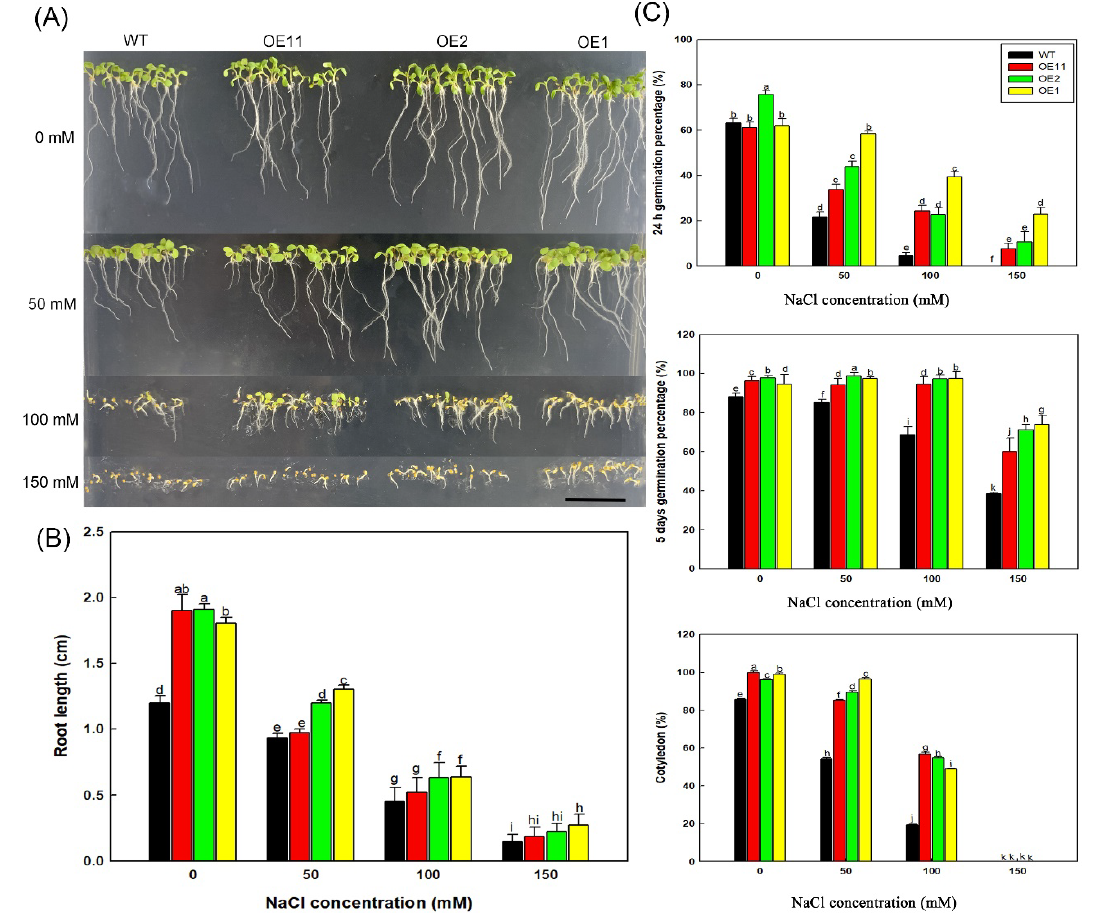
Figure 4. Lb1G04202 increased the salt resistance of Arabidopsis during germination. ( A ) Col-35S:: Lb1G04202 seeds grown on medium with different concentrations of NaCl (0, 50, 100, and 150 mM) for 5 d. Bar = 1 cm. ( B ) Root lengths of 5-d-old seedlings were determined using ImageJ software. Thirty seedlings were analyzed per line. Root length data are the mean ± SD of 30 plants. ( C ) Analysis of germination levels and cotyledon growth under different NaCl treatments. Germination percentage was measured at 48 h and 5 d after sowing. Forty seeds per line were sown per treatment, and three replicates were performed. Germination percentage data are the mean ± SD of 40 plants. The cotyledon growth rate (expressed as the percentage of plants with emerged cotyledons) was calculated 3 d after sowing on different media. Forty seeds per line were sown per treatment, and three replicates were performed. Cotyledon growth rate data are mean ± SD of 40 plants. Different letters indicate significant differences at p = 0.05 according to Duncan’s multiple range test.